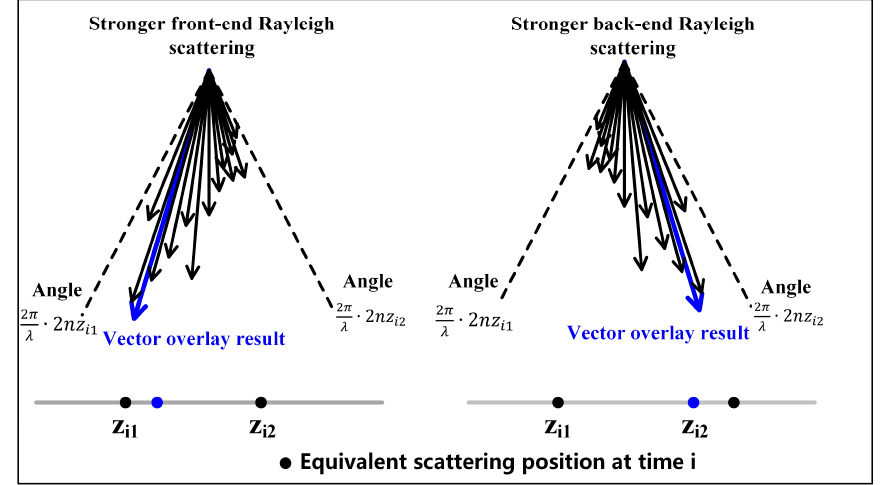
Figure 4. Schematic diagram of equivalent scattering positions in pulse interference.